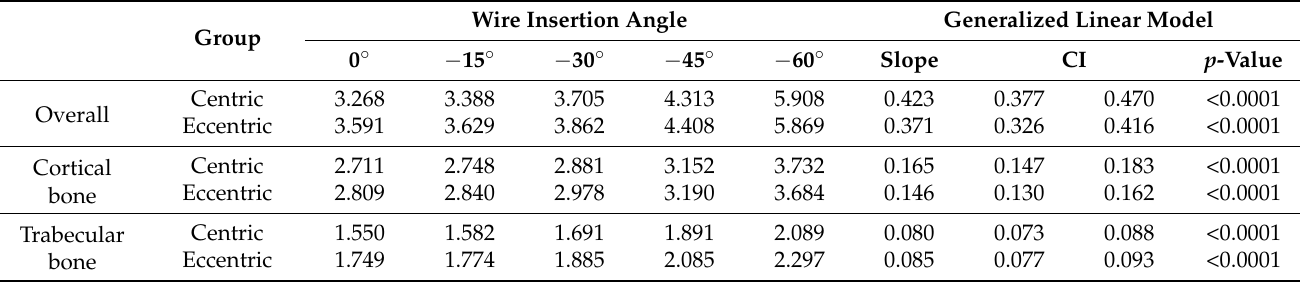
Table 5. Moment (Nmm) required to unwind the miniscrew for 1 ◦ of counter-clockwise rotation at each component of finite element model according to the position of the hole at the head part and the negative wire insertion angles.